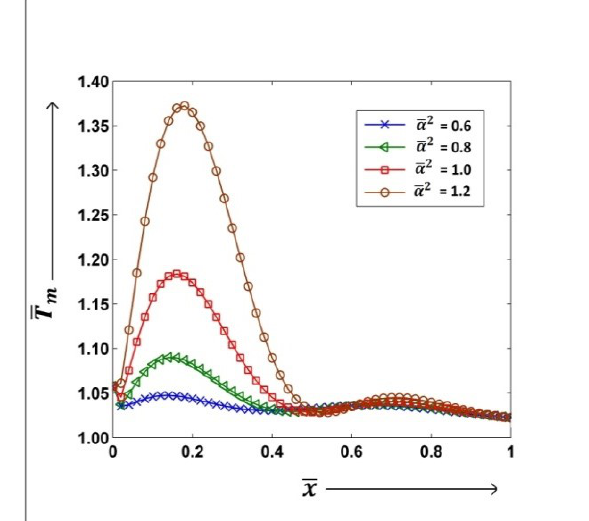
Fig. 5: Mean temperature vs. Magnetic parameter at 1/¯ s = 1, ¯ α 2 =